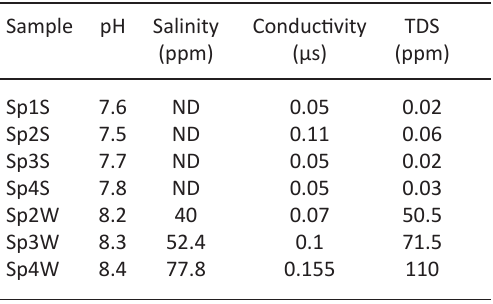
Table 1. Physicochemical analysis of Sand Dune Samples of Thar Desert Sample